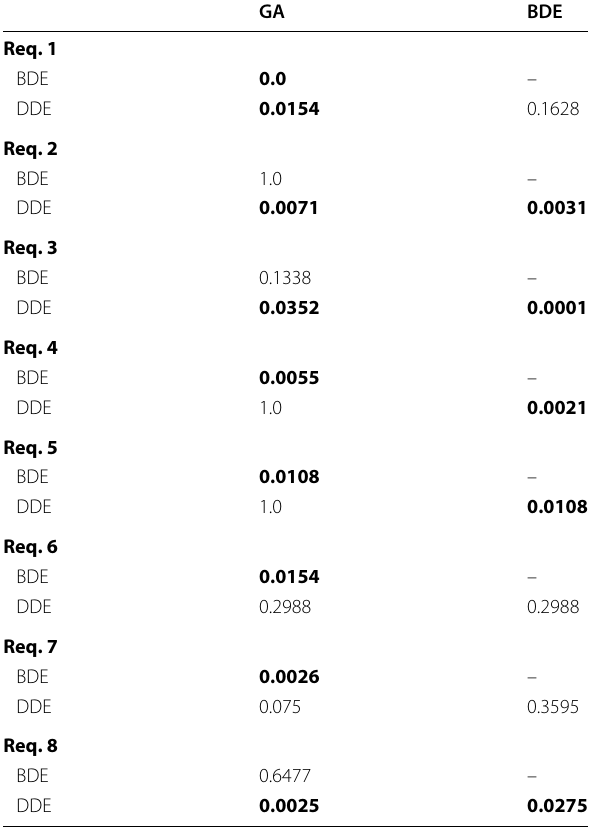
Table 10 Dunn test with Bonferroni α correction for the hit values in Table